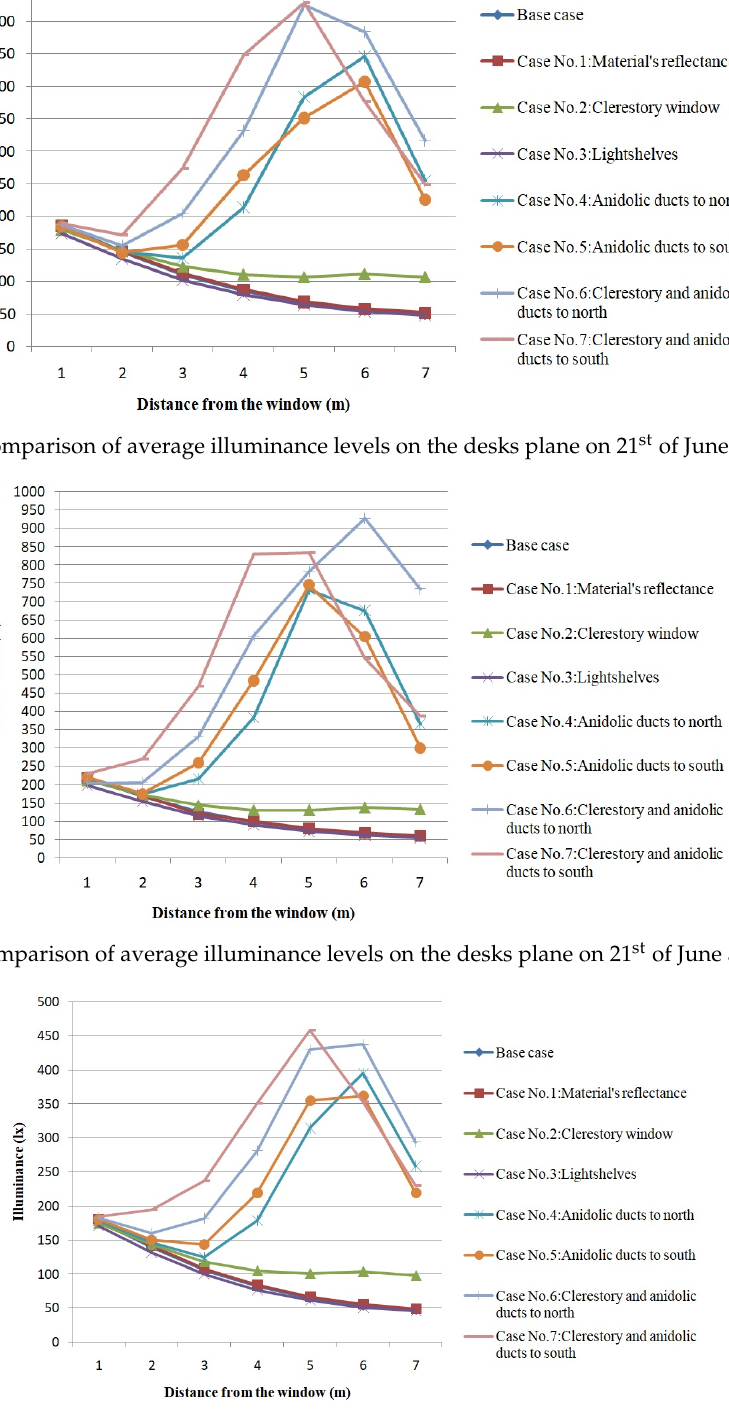
Figure 20. Comparison of average illuminance levels on the desks plane on 21 st of June at 3:00 pm.